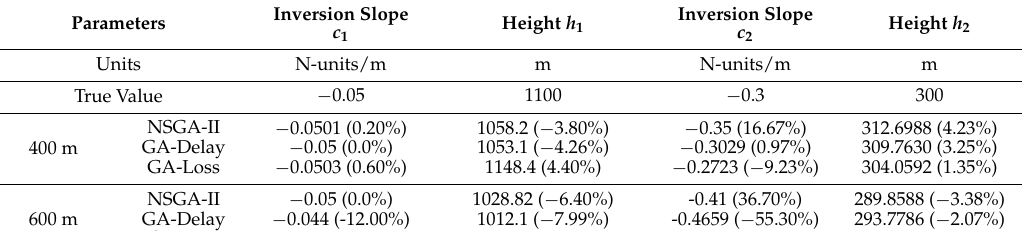
Table 3. The value of inversion parameters.